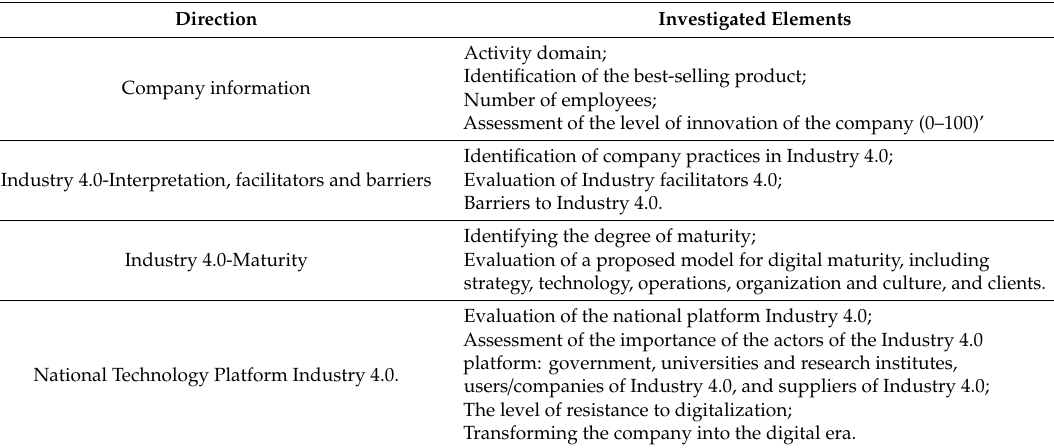
Table 1. Sustainable development and Industry